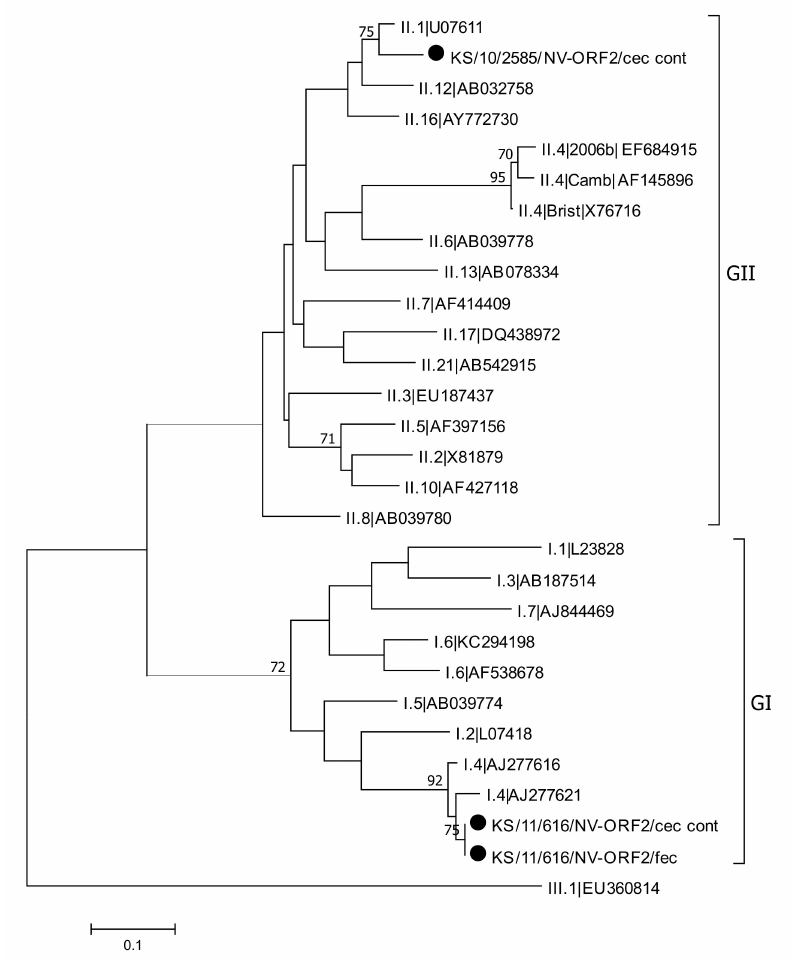
Figure 7. Phylogenetic analysis of a 255 nt fragment of ORF2 from norovirus strains detected in this study (marked with a dot), human norovirus reference sequences and a single sequence that was detected in a rat from Copenhagen, Denmark (GI.6|KC294198). The phylogenetic tree was reconstructed using the Neighbor-Joining method with Bootstrap test (1000 replicates) and the Kimura 2-parameter method available in MEGA7. The bar indicates the number of substitutions per site. A bovine norovirus sequence (GIII.1|EU360814) was used as an outgroup. Bootstraps values above 70 are shown. Abbreviations: cec = cecum; cont = content; fec =